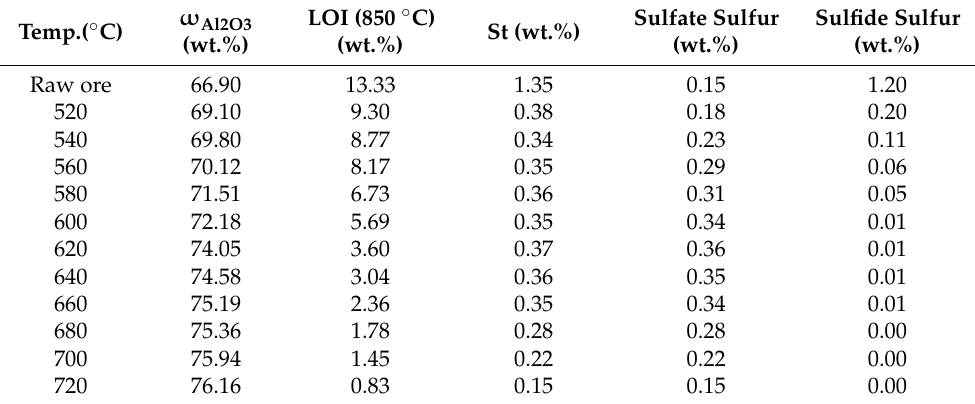
Table 4. Analysis results of ore roasted at various roasting temperatures for approx. 2 s.